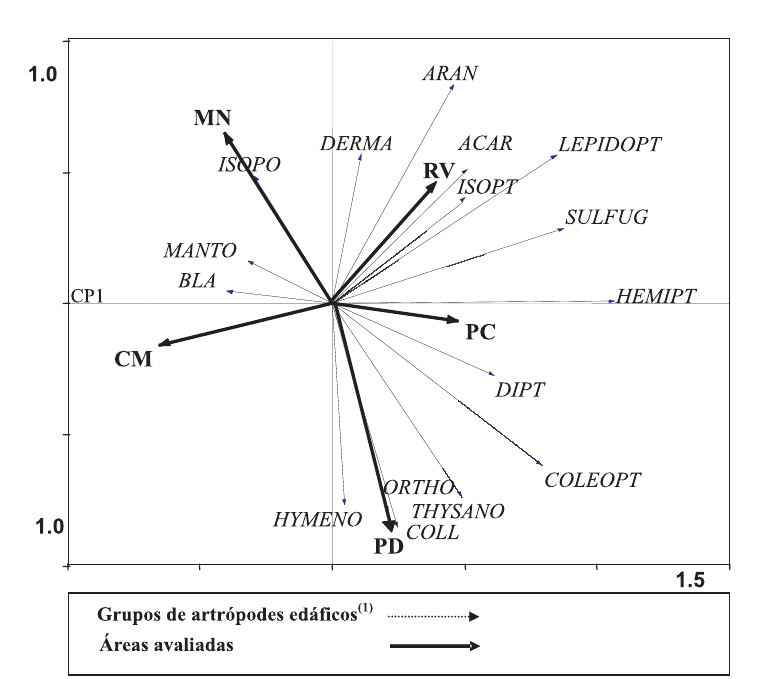
Figura 2. Análise dos Componentes Principais (PCA) da relação entre grupos de artrópodes edáficos e as áreas Plantio Convencional (PC), Cultivo Mínimo (CM), Plantio Direto (PD) de tabaco, Reconversão para Vitivinicultura (RV) e Mata Nativa (MN). (1) Grupos de artrópodes edáficos: DERM (Dermaptera); ARA (Araneae); ACA (Acarina); ISOP (Isoptera); LEPIDOP (Lepidoptera); SULFU (Sulfugida); HEMIP (Hemiptera); DIP (Diptera); COLEOP (Coleoptera); THYSAN (Thysanoptera); ORTH (Orthoptera); COL (Collembola); HYMEN (Hymenoptera); BL (Blastodea); MANT (Mantodea); e ISOPO